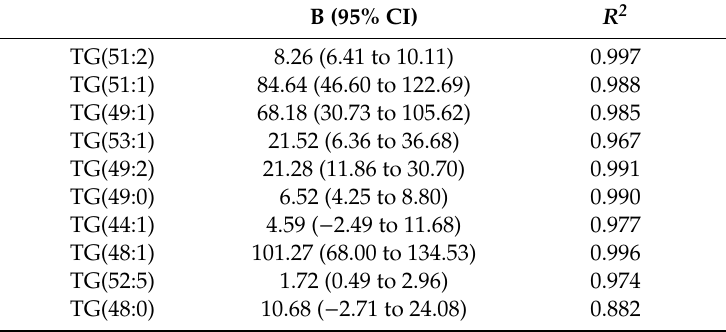
Table 3. Associations between plasma FABP4 and liver triglycerides identified by both LC–MS and LDI–MS tissue imaging in the HFD-fed mice. Multiple linear regression results are shown as β -coe ffi cients with CIs and R 2 values. Triglycerides are displayed as the dependent variables. B (95% CI) R